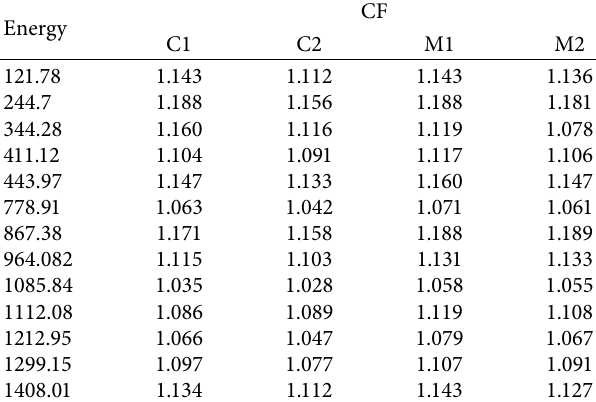
Table 5: The correction factor of the coincidence summing effect using different radioactive volumetric sources.